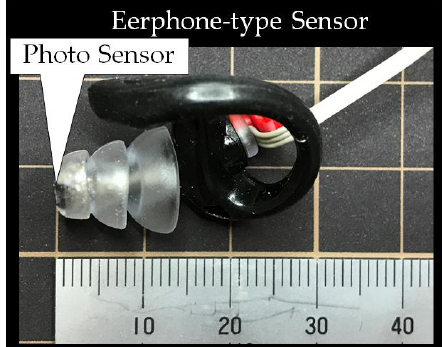
Figure 3. Earphone-type sensor for the right ear. The earphone-type sensor is equipped with a small optical sensor comprising a QRE 1113 sensor (Fairchild Semiconductor International Inc., San Jose, CA, USA). An infrared LED and phototransistor is equipped in the optical sensor. The size of the area that is used for the earphone-type sensor to be inserted into the ear canal was based on a medium sized commercially available earphone. Speakers were not mounted onto the sensor in this study, because the objective here is only to evaluate the operating performance of a PAP using a prototyped earphone-type sensor; however, speakers can be added in future applications.